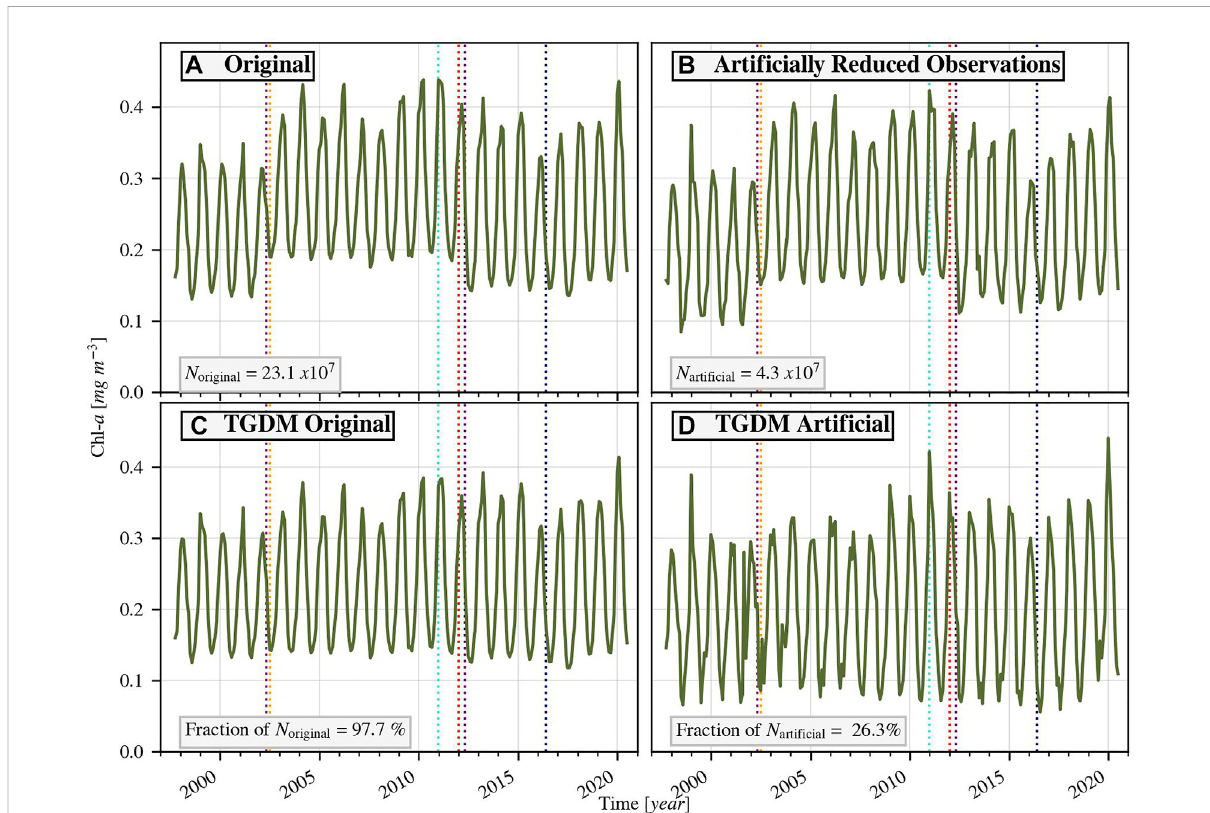
FIGURE 7 TheperformanceoftheTGDMondatasetswithdifferingcoveragedensities: (A) Themonthly-averagedChl -a timeseriesoftheMediterranean Sea and (B) the Mediterranean Sea data set with arti fi cially reduced observations. The indicated numbers N original and N arti fi cial represent the total count of observations. Panels (C) and (D) represent the monthly-averaged Chl -a time series after applying the TGDM to the original Mediterranean Seaandthearti fi cialMediterraneanSea,respectively.ThefractionsofthetotalobservationsthatremainafterTGDMareindicatedas “ Fractionof N ” . Vertical lines indicate changes in sensor contributions (colouring speci fi ed in Figure